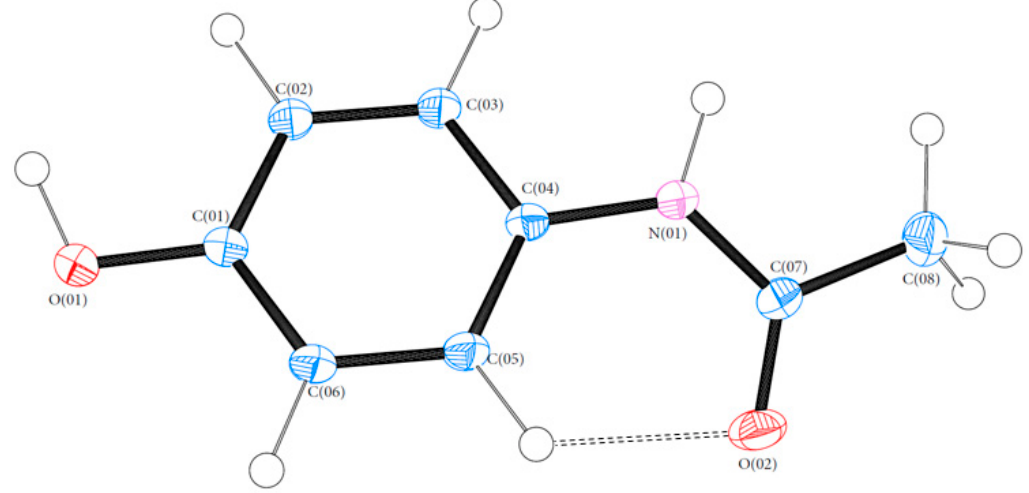
Figure 2. ORTEP diagram of PCM ( 1 ). Thermal ellipsoids are shown at the 50% probability level [24].